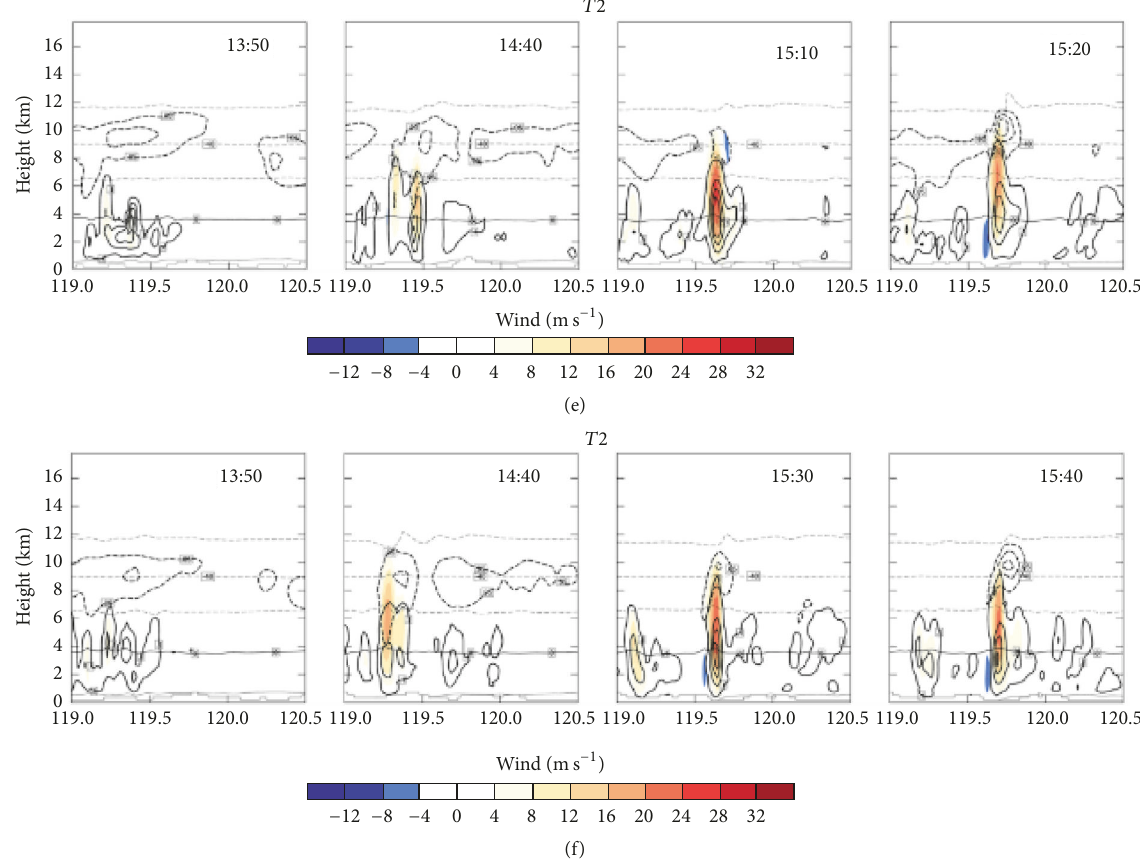
Figure 7: Cross section of the simulated cloud water mixing ratio (solid line, minimum 0.1g ⋅ kg −1 , interval 1g ⋅ kg −1 ), ice crystal mixing ratio (black dotted line, minimum 0.05 g ⋅ kg −1 , interval 0.1g ⋅ kg −1 ), and updraft (colored) and isothermal line (dashed gray line) in latitudinal direction: (a) original; (b) Philips; (c) Cooper; (d) Fletcher; (e) Chi NJ; and (f) Chi